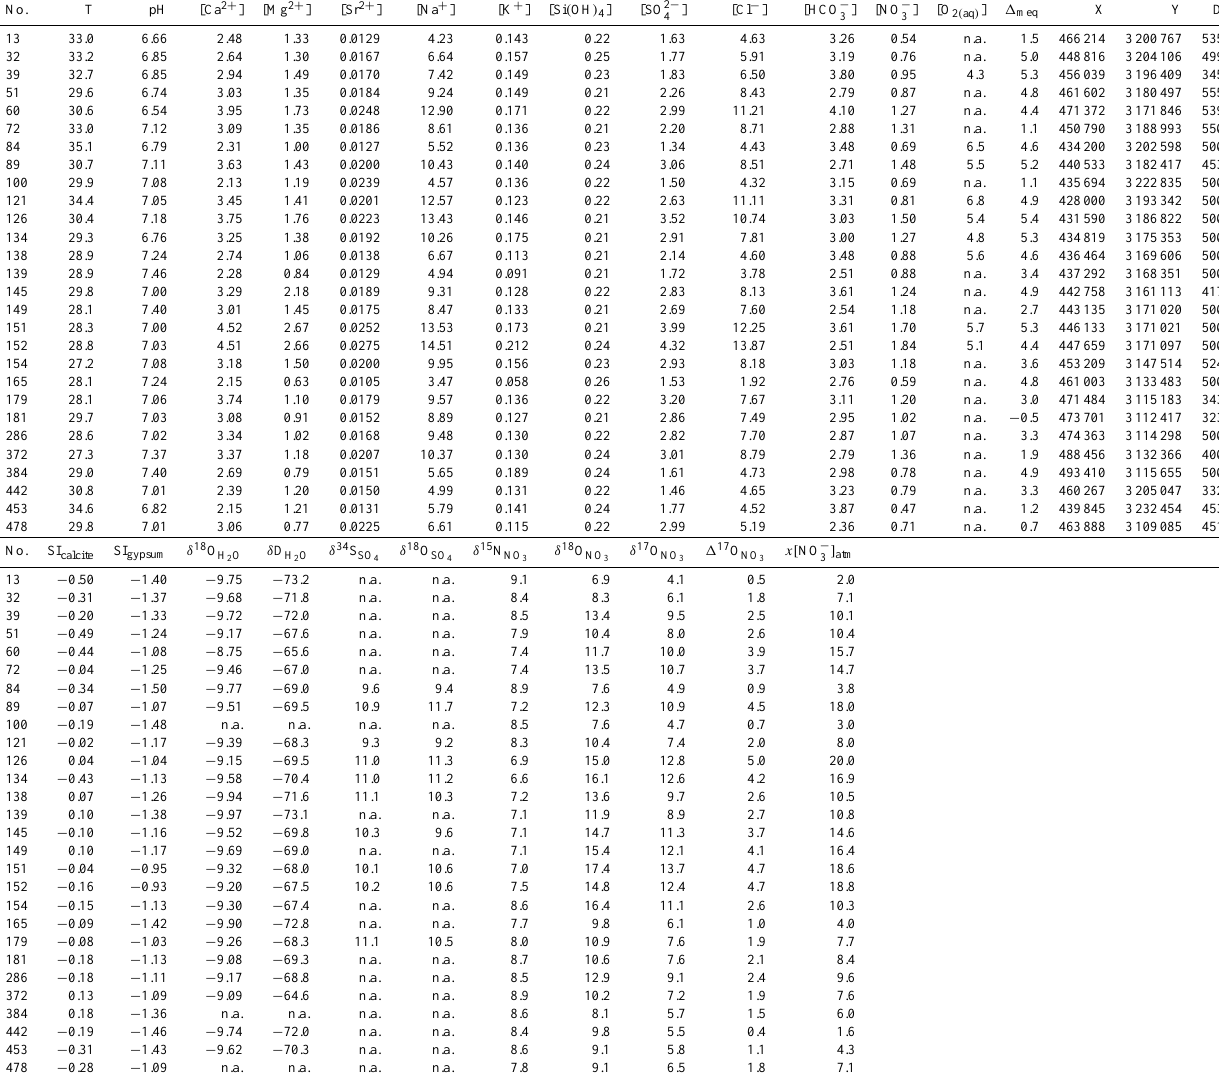
Table 1. Composition of Saharan paleo-groundwater from wells of the Hasouna area (Libya). No.: Well number (see Fig. 1). T: Temperature in ◦ C. [ ]: Concentrations are given in mM, except for O 2 ( aq ) in mgL − 1 . 1 eq : Derivation from electrical neutrality in meq%. Site positioning of the wells is given in coordinates X and Y and well depths, D, in metres. δ 18 O H and δ D H values of the groundwaters are given in ‰ 2 O 2 O (VSMOW). δ 34 S SO and δ 18 O SO values for the isotope composition of dissolved SO 2 − are related to the VCDT and VSMOW standards, 4 4 4 respectively, and given in ‰. δ 15 N NO , δ 18 O NO , δ 17 O NO and 1 17 O NO values of the dissolved NO − are given in ‰ relative to the AIR 3 3 3 3 3 ] atm : Proportion of dissolved NO − and VSMOW standards, respectively. x [ NO − from atmospheric origin with respect to total dissolved 3 3 NO − in 3